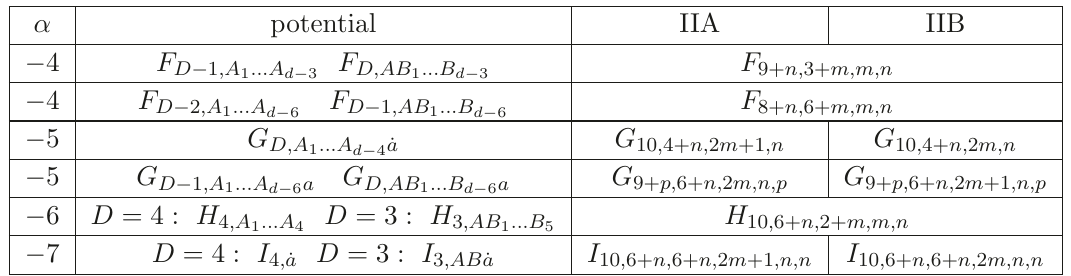
Table 2 . The potentials associated to all the branes of the maximal theory in four dimensions and above that are not related by T-duality to branes that occur in ten dimensions. In the second column we list the D -dimensional potentials as representations of SO( d, d ), while in the third and fourth column we list the corresponding ten-dimensional mixed-symmetry potentials. For α = − 4 and α = − 6 the IIA and IIB potentials are the